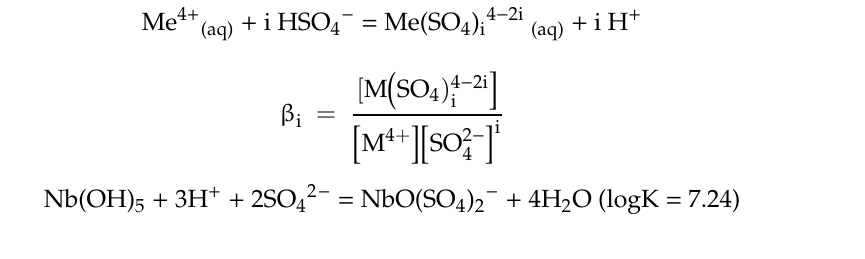
Table 2. Stability constants of sulphate complexes of zirconium and hafnium. Stability Constant